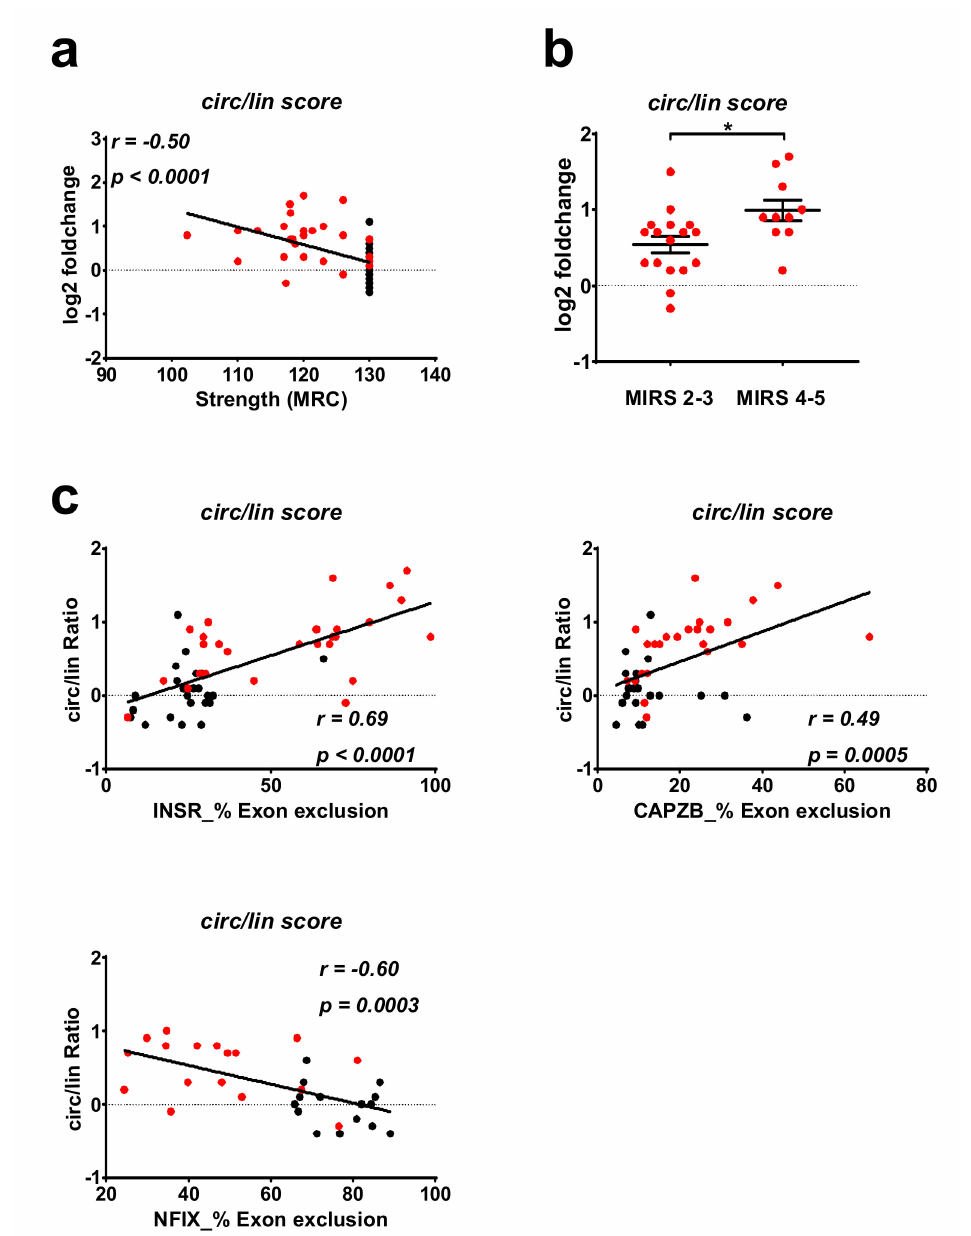
Figure 4. Correlation of DM1-relevant parameters with the circular-to-linear score of DM1-circRNAs. ( a ) Pearson correlation of the circular-to-linear score (obtained by averaging all DM1-circRNA fractions) with muscle strength measured by MRC megascore. ( b ) DM1 patients were divided according to (Muscular Impairment Rating Scale) MIRS classes. T -test statistics identified a significant increase (* p < 0.05) of the circular-to-linear score in patients belonging to higher MIRS classes (4–5) compared to lower MIRS classes (2–3). ( c ) Pearson correlation of circular-to-linear scores with percentages of exons exclusion of INSR, CAPZB (DM1 = 30, CTRL = 29), and NFIX (DM1 = 17, CTRL = 15). Red dots = DM1, black dots =